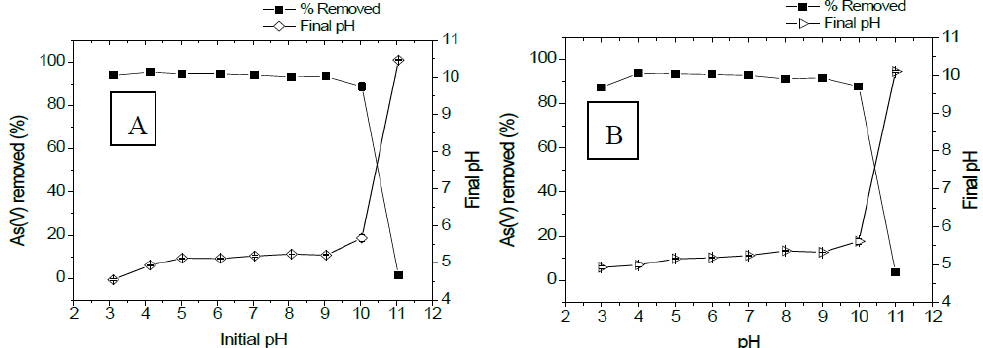
Figure 7. Effect of initial pH on removal of As(V) by ( A ) Ch–Rs ( B ) Ch–Pu blends (initial As(V) concentration 0.25 mg/L, adsorbent dose 8 g/L, shaking 2 h at 200 rpm at 24 ± 1 °C).